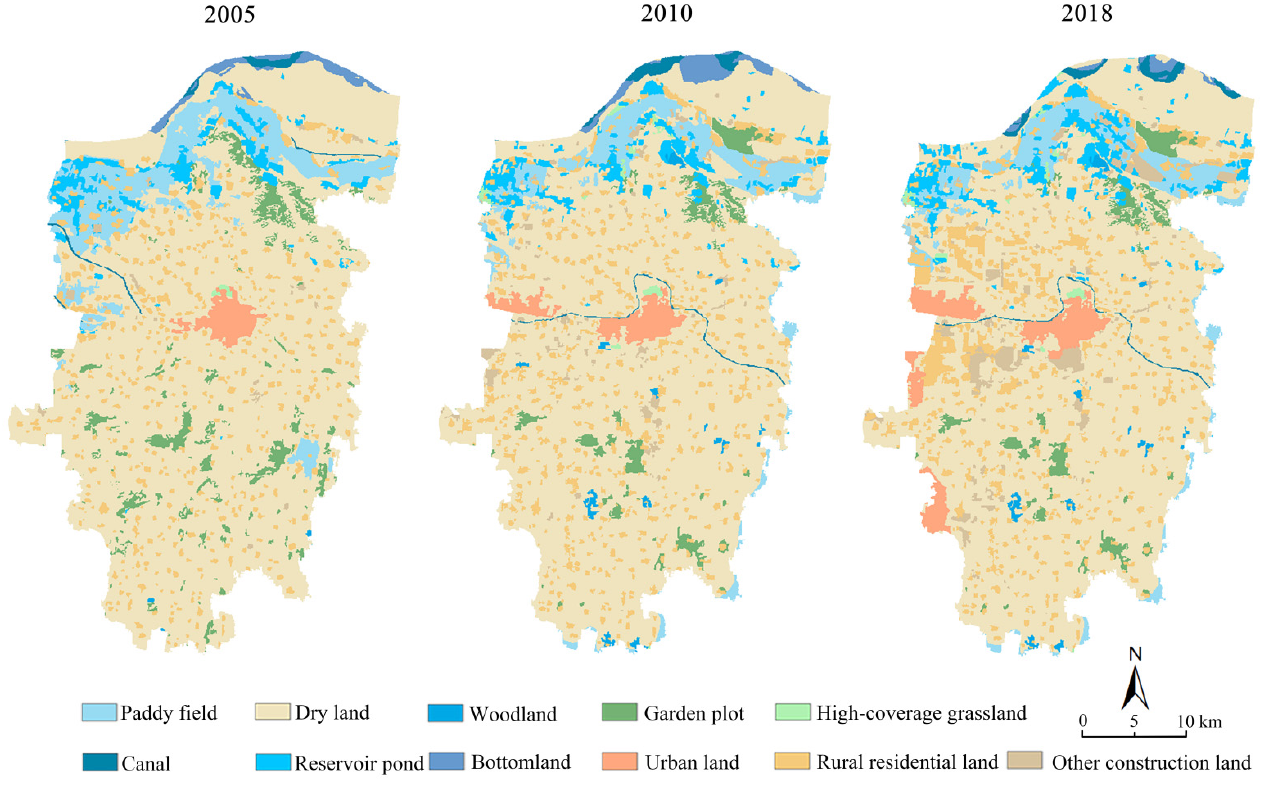
Table 2. Changes in landscape level pattern index.